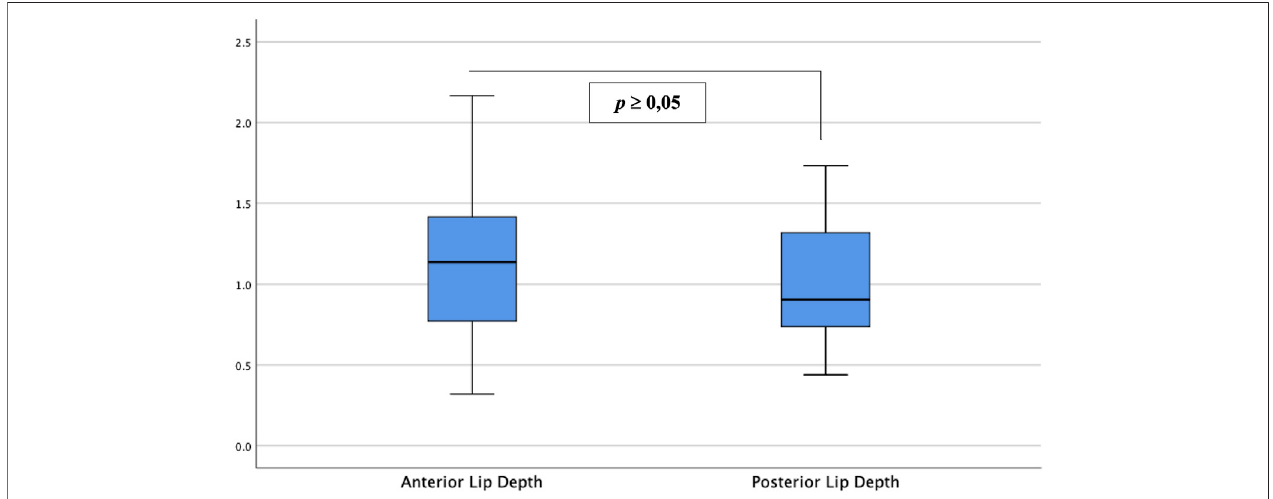
FIGURE4| Depthofanteriorandposteriorcervicalliptissuedestruction.Betweenthetwogroups,therewasnosigni fi cantdifferenceindepthoftissuedestruction between anterior and posterior cervical lips ( p ≥ 0.05).